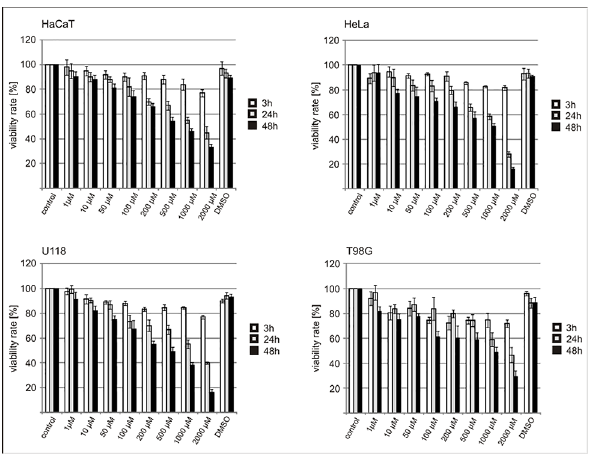
Fig 6. The effect on cell viability after temozolomide treatment estimated by MTT assay. Normal (HaCaT) and tumor cells (HeLa, T98G and U118)were treated with different TMZ concentrations (1